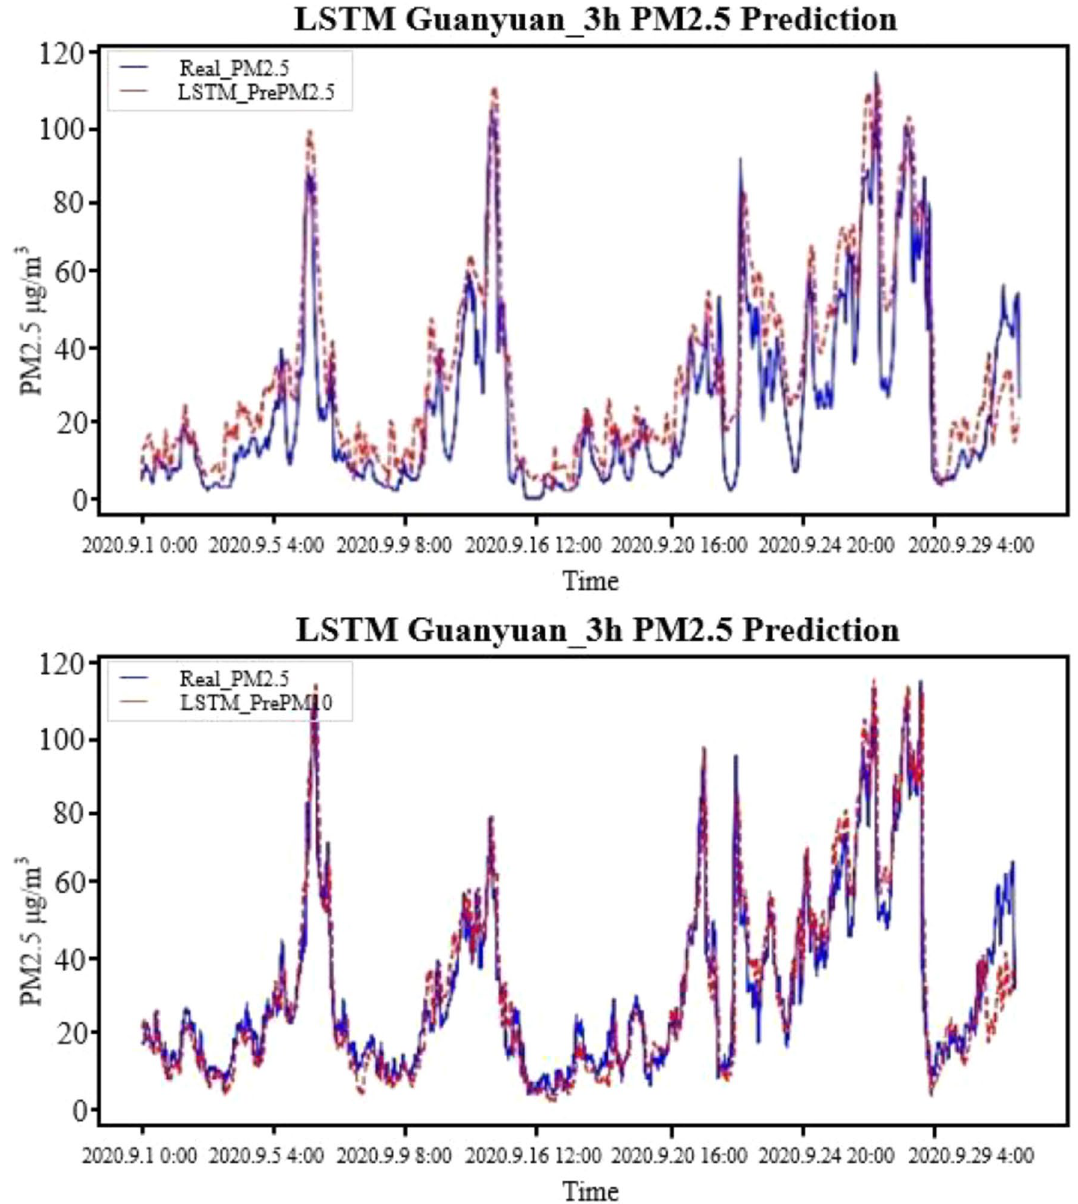
Figure 8. LSTM 3-h input factor normalized PM 2.5 pollutant prediction fitting